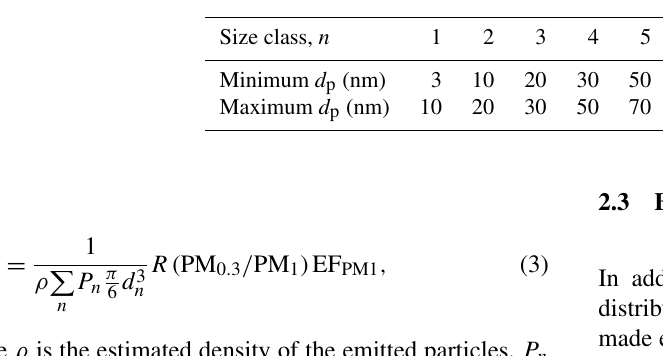
Table 1. The diameter ranges of particles in the size classes applied for PN emissions. Diameters are electrical mobility diameters, except for * aerodynamic diameter (see